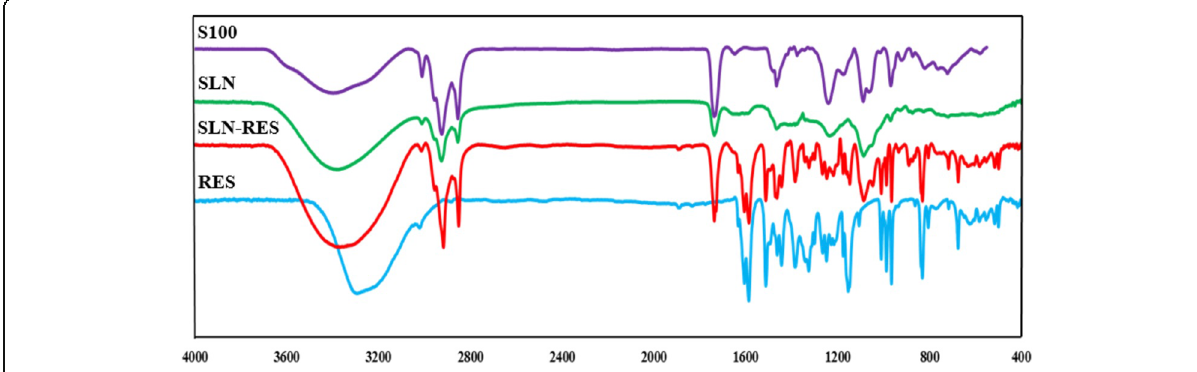
Fig. 3 FTIR spectrum of SLN (solid lipid nanoparticle), SLN-RES (resveratrol-loaded solid lipid nanoparticle), S100 (lecithin), and RES (pure resveratrol powder)